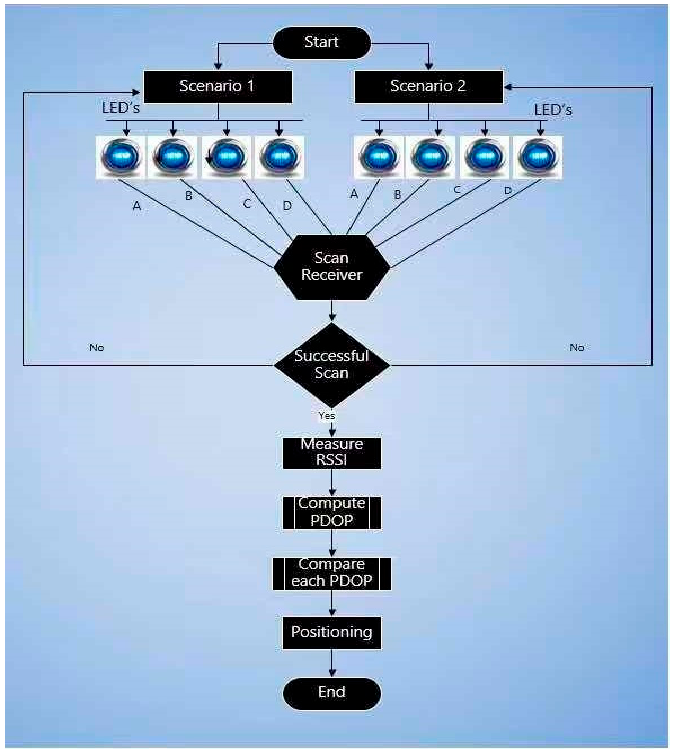
Figure 3. Schematic representation of the positioning algorithm based on positional dilution of precision (PDoP). Note: RSSI = received signal strength indicator.